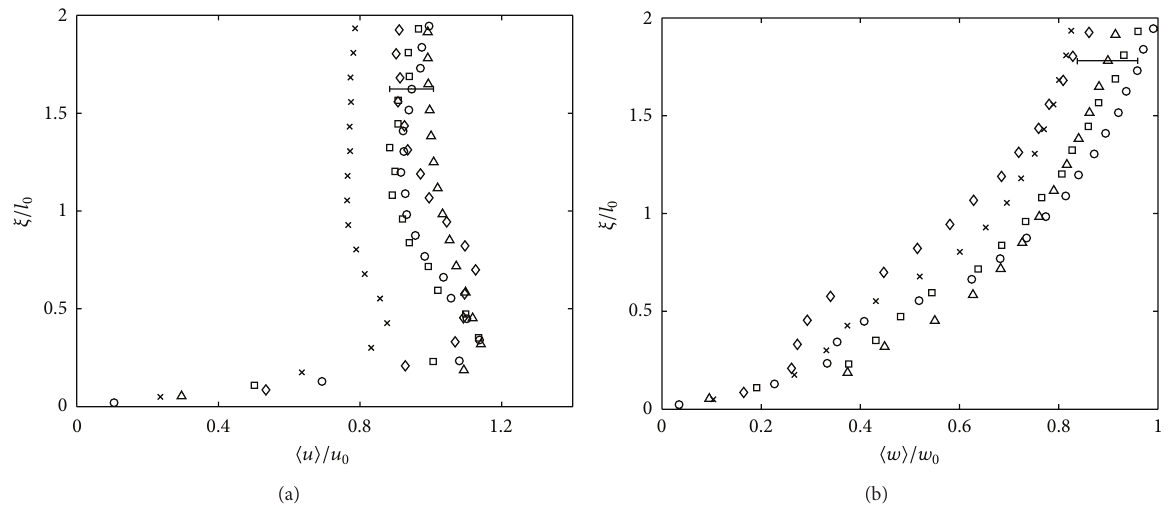
Figure3:Plotsshowingmeasurementsof(a) ⟨𝑢⟩/𝑢 0 and(b) ⟨𝑤⟩/𝑤 0 againstdimensionless 𝜉/𝑙 0 ,distanceabovethetankbase.Theexperiments shown correspond to 𝑅𝑒 𝑙 = 570 ( ∘ ), 𝑅𝑒 𝑙 = 474 ( ◻ ), 𝑅𝑒 𝑙 = 325 ( 󳵻 ), 𝑅𝑒 𝑙 = 209 ( ⬦ ), and 𝑅𝑒 𝑙 = 117 ( × ). To avoid saturation, a single error bar has been included in each plot which is representative of the variability observed in all of the data shown.